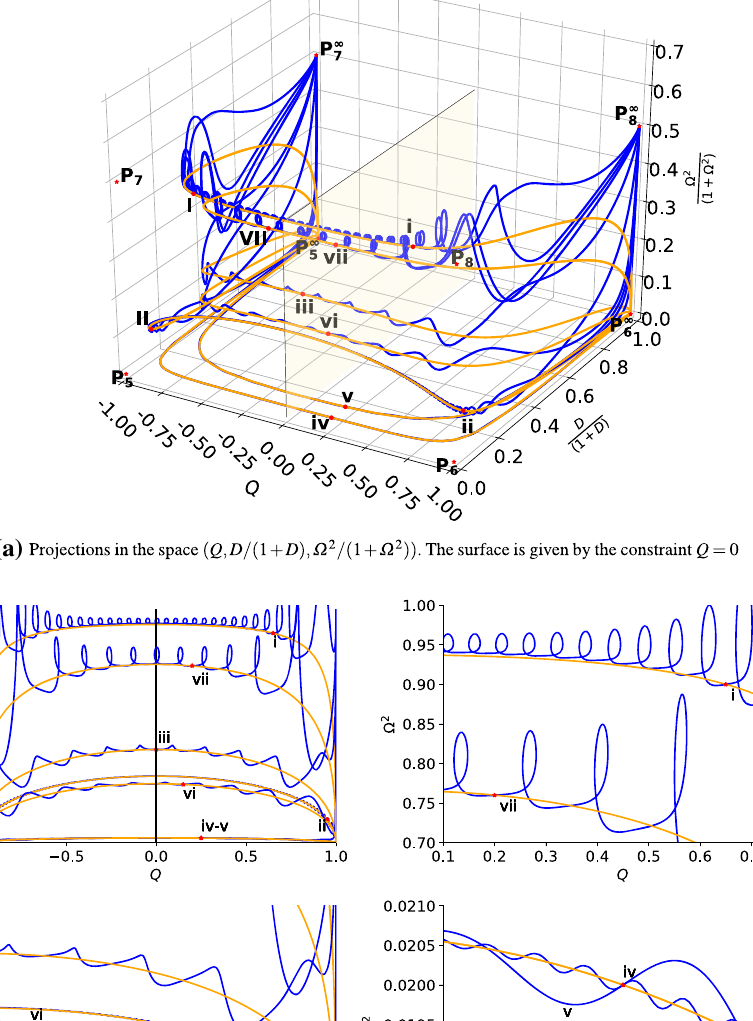
Fig. 23 Some solutions of the full system (118) (blue) and time-averaged system (145) (orange) for the FLRW metric with positive curvature ( k = + 1) when γ = 4 . We have 3 used for both systems the initial data sets presented in Table